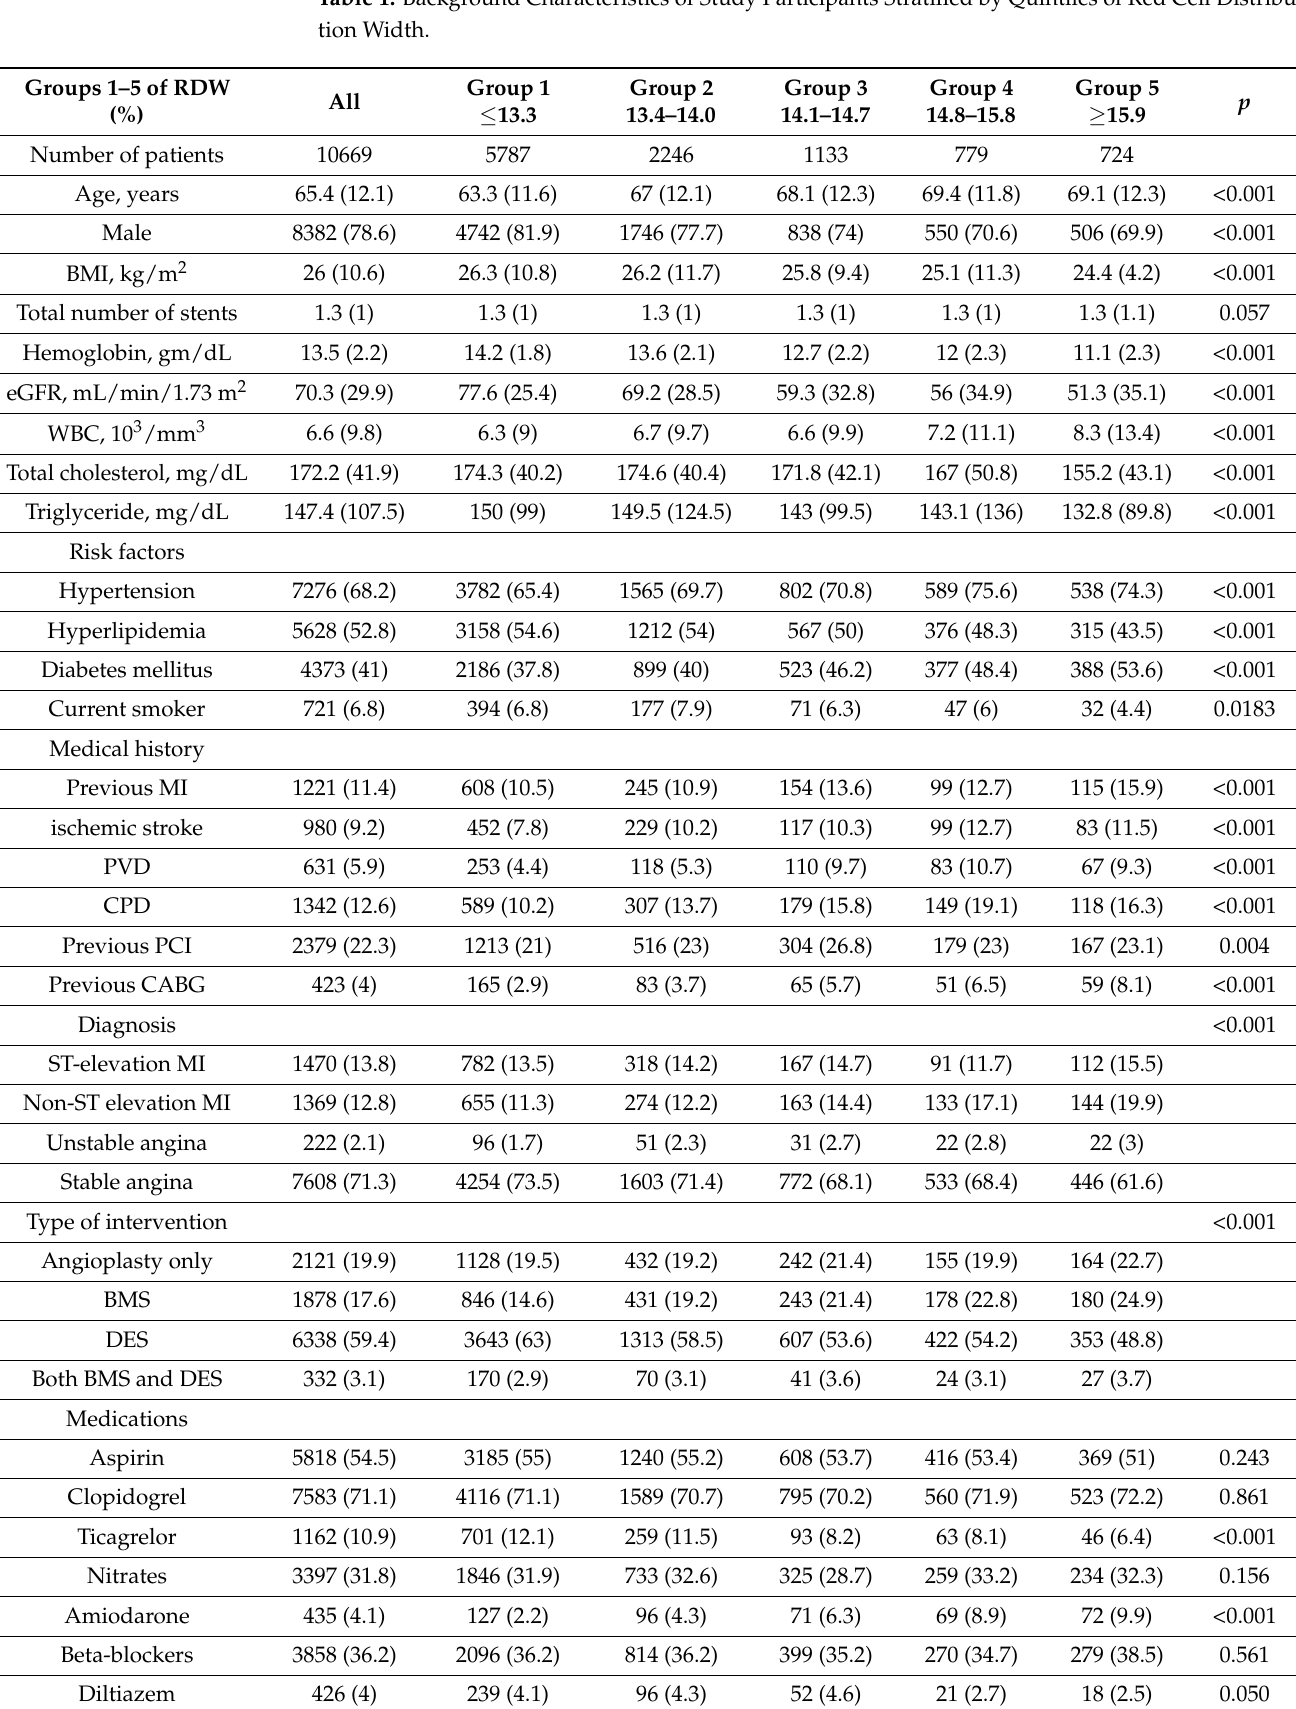
Table 1. Background Characteristics of Study Participants Stratified by Quintiles of Red Cell Distribu- tion